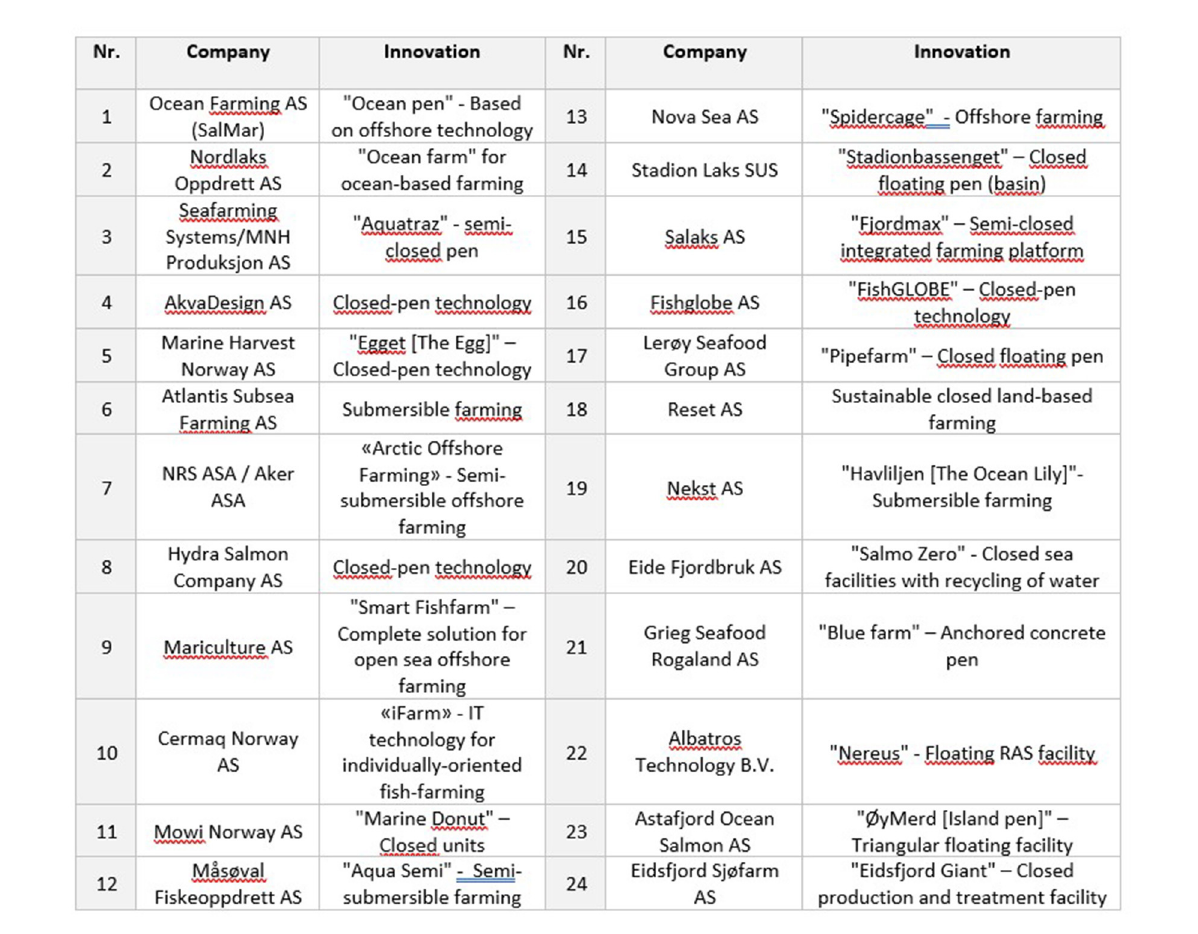
FIGURE2 Table of projects that have received development licenses [Source: https://www.fiskeridir.no/Akvakultur/Tildeling-og-tillatelser/Saertillatelser/ Utviklingstillatelser/Status-ja-nei-antall-og-biomasse (accessed March,